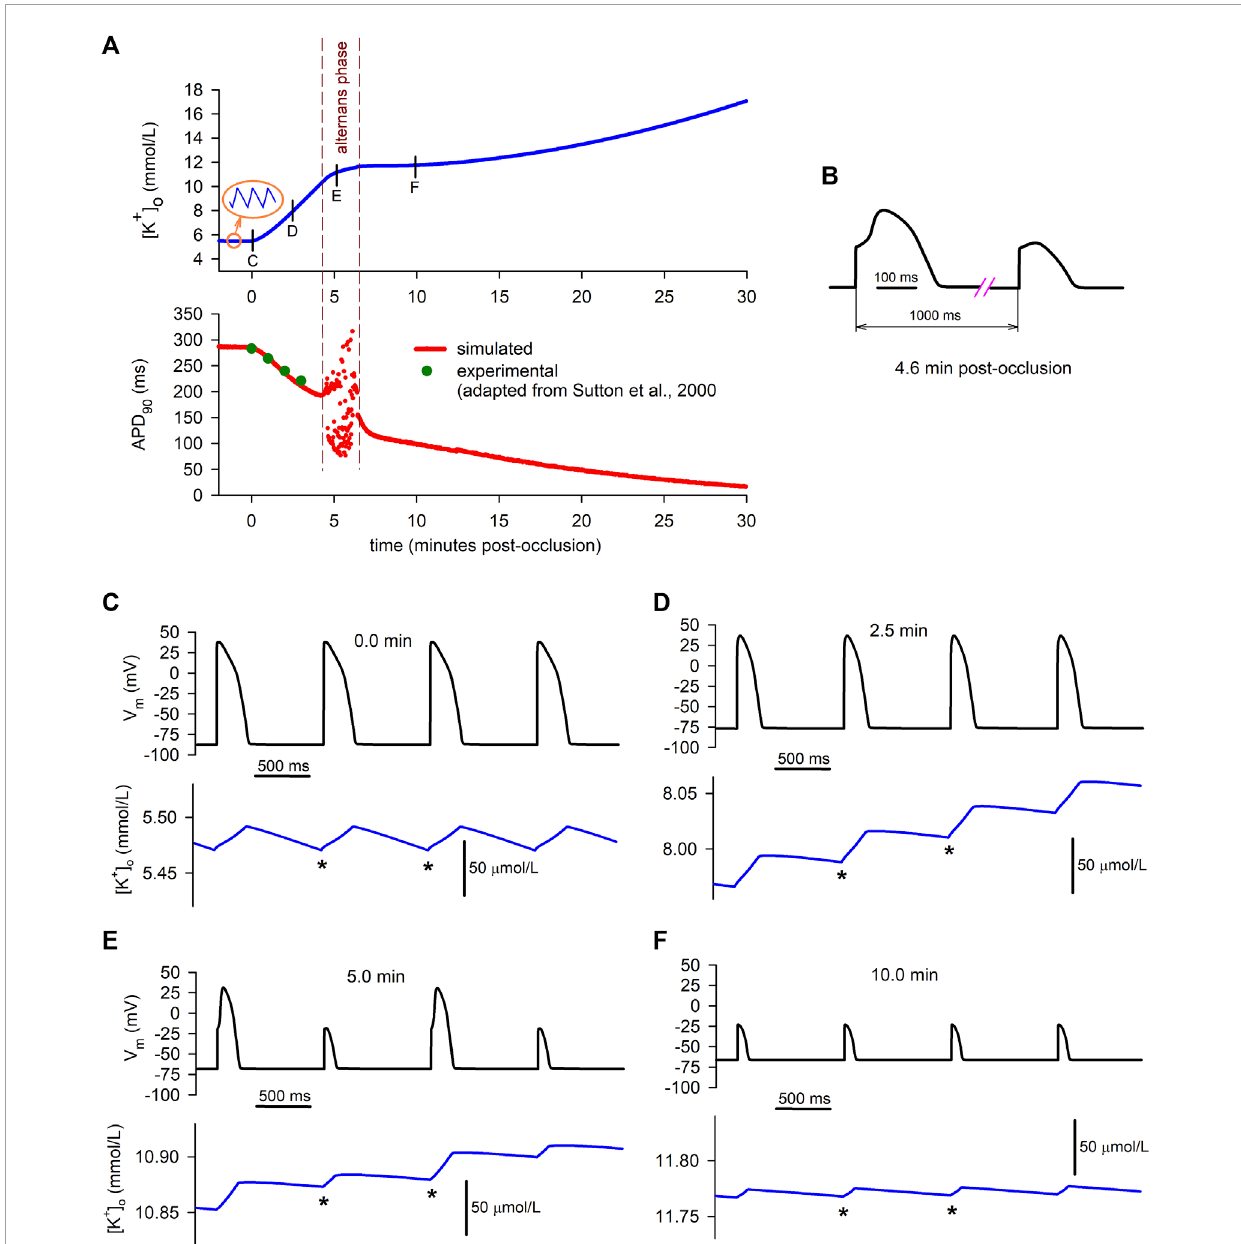
FIGURE 5 Relationship between simulated extracellular potassium concentration and APs. (A) : time course of [ K + ] o (upper graph) and APD at 90% repolarization (lower graph), showing the AP alternating phase (dashed vertical lines). (B) : simulated AP alternans corresponding to the 4.6 min mark. The time axis has been broken to enhance the shape of the “short” and “long” APs. (C–F) : Action potentials (upper black traces) and [ K + ] o (lower blue traces) showing the “micro” fluctuations in extracellular potassium concentration. The * symbols indicate diastolic minimum potassium levels.